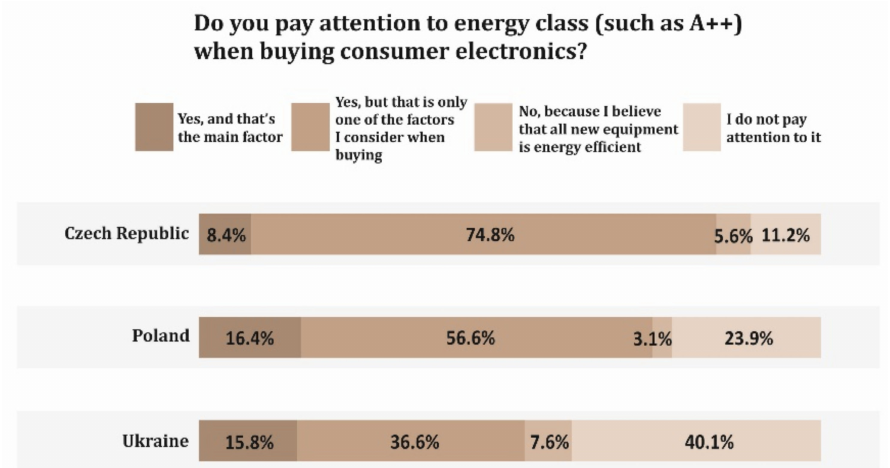
Figure 5. Distribution of answers to the question whether respondents pay attention to the energy class of the device upon a purchase. Source: own